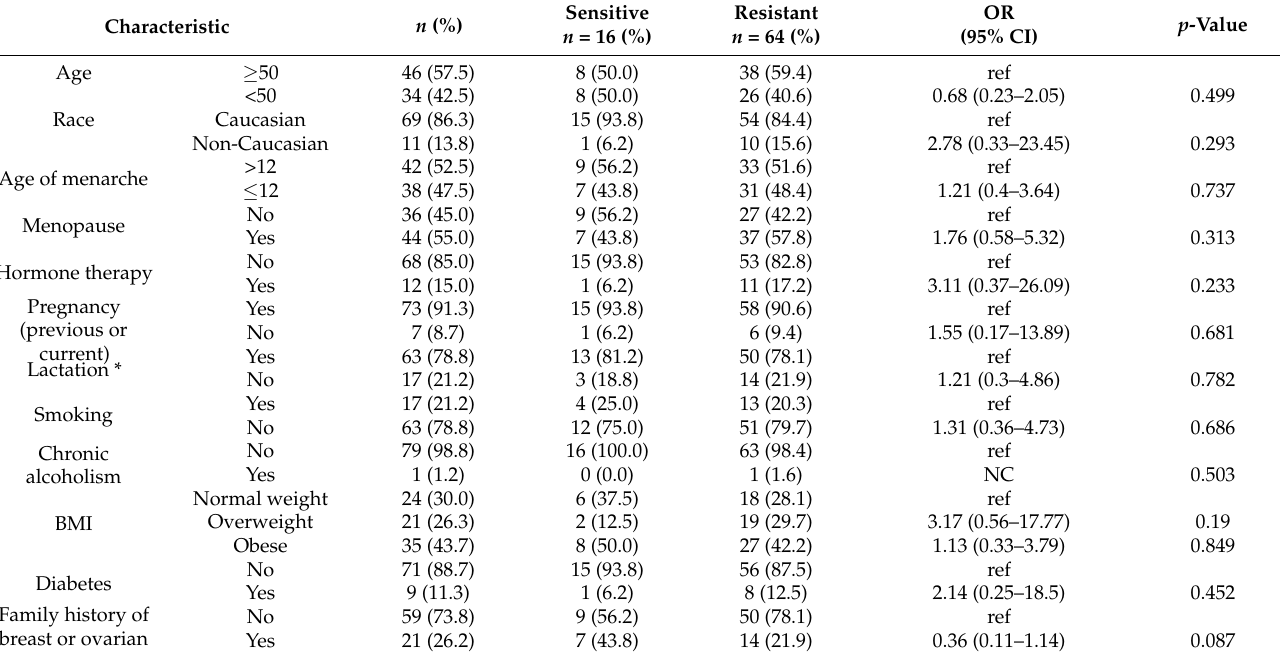
Table 1. Key patient information as related to response to neoadjuvant